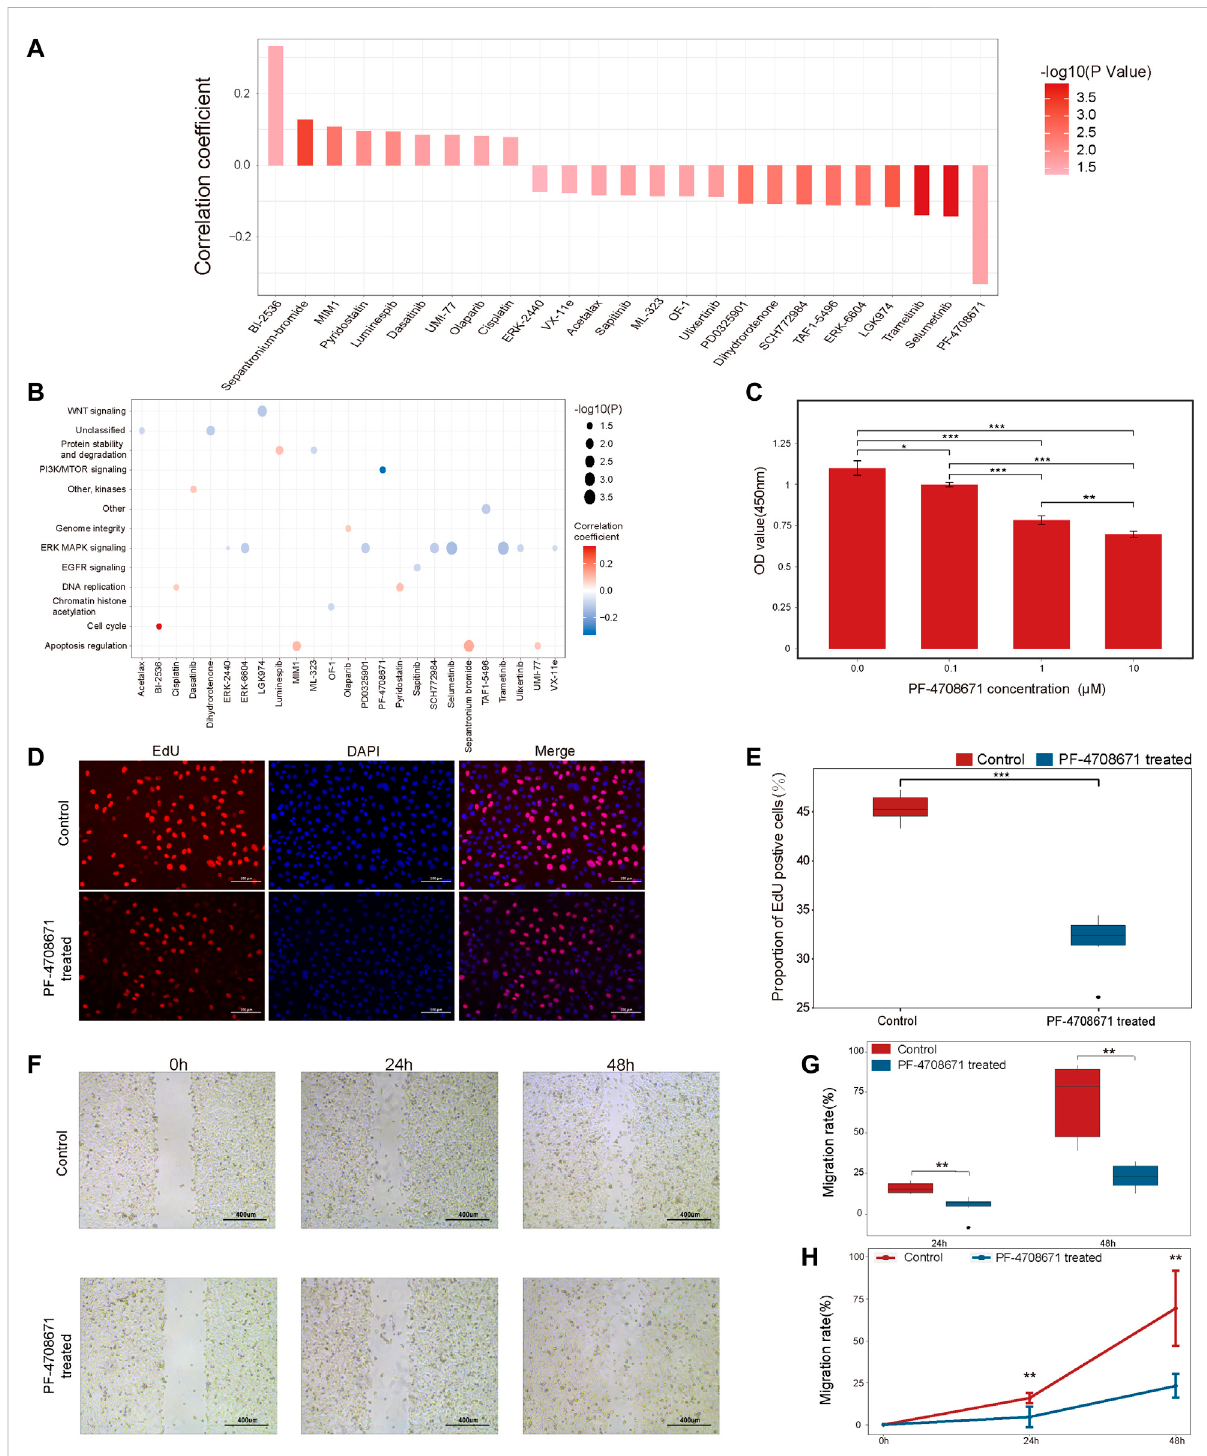
FIGURE 7 The potential alternative drug for patients resistant to anti-PD1/PDL1 therapy, (A) The correlation between the TSIRS and drug IC50 value. (B) Targeting pathways of the drugs. (C) The effect of PF-4708671 on the viability of cancer cells. (D) Representative images of EdU staining. Scale bar: 100 μ m. (E) The effect of PF-4708671 on the proliferation ability of cancer cells. n = 6. (F) Representative images of wound healing assay. Scale bar: 400 μ m. (G,H) TheeffectofPF-4708671incancercellspresentedastheboxplot (G) andlinechart (H) . n =6.* p < 0.05,** p < 0.01,*** p <